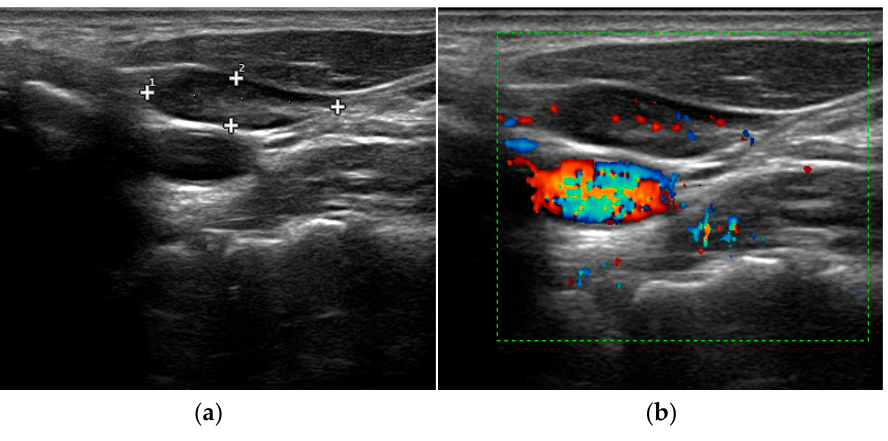
Figure 3. Grey-scale ( a ) and Color Doppler ( b ) aspect of cervical lymph node. However, these findings are not common in all parathyroid lesions and cervical lymph nodes [68]. Benign cervical lymph nodes generally display centrifugal and